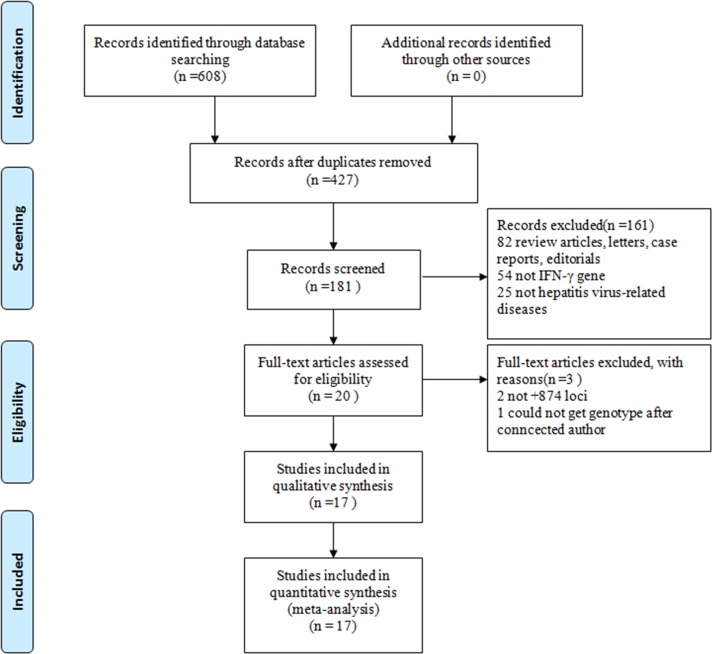
Flow diagram of included studies for this meta-analysis.